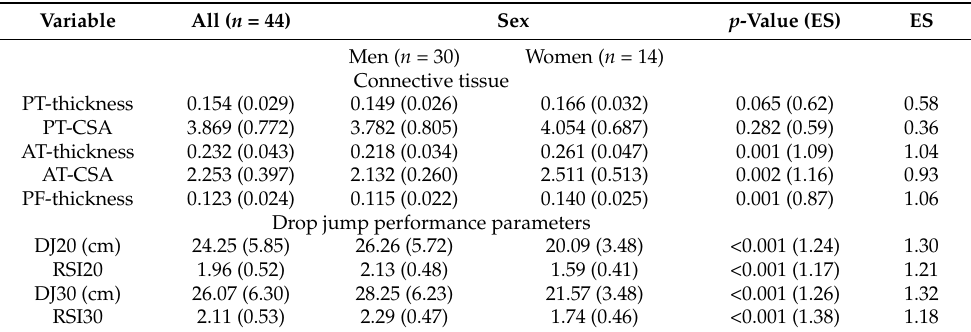
Table 2. Morphology of the normalized to body mass connective tissue and drop jump performance parameters regarding sex.